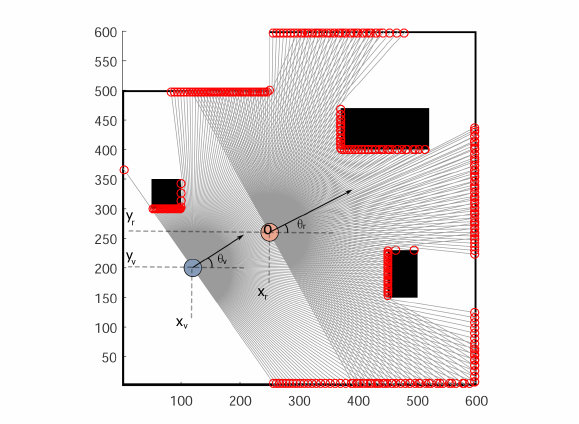
Figure 2. Robot configuration in two-dimensional space.